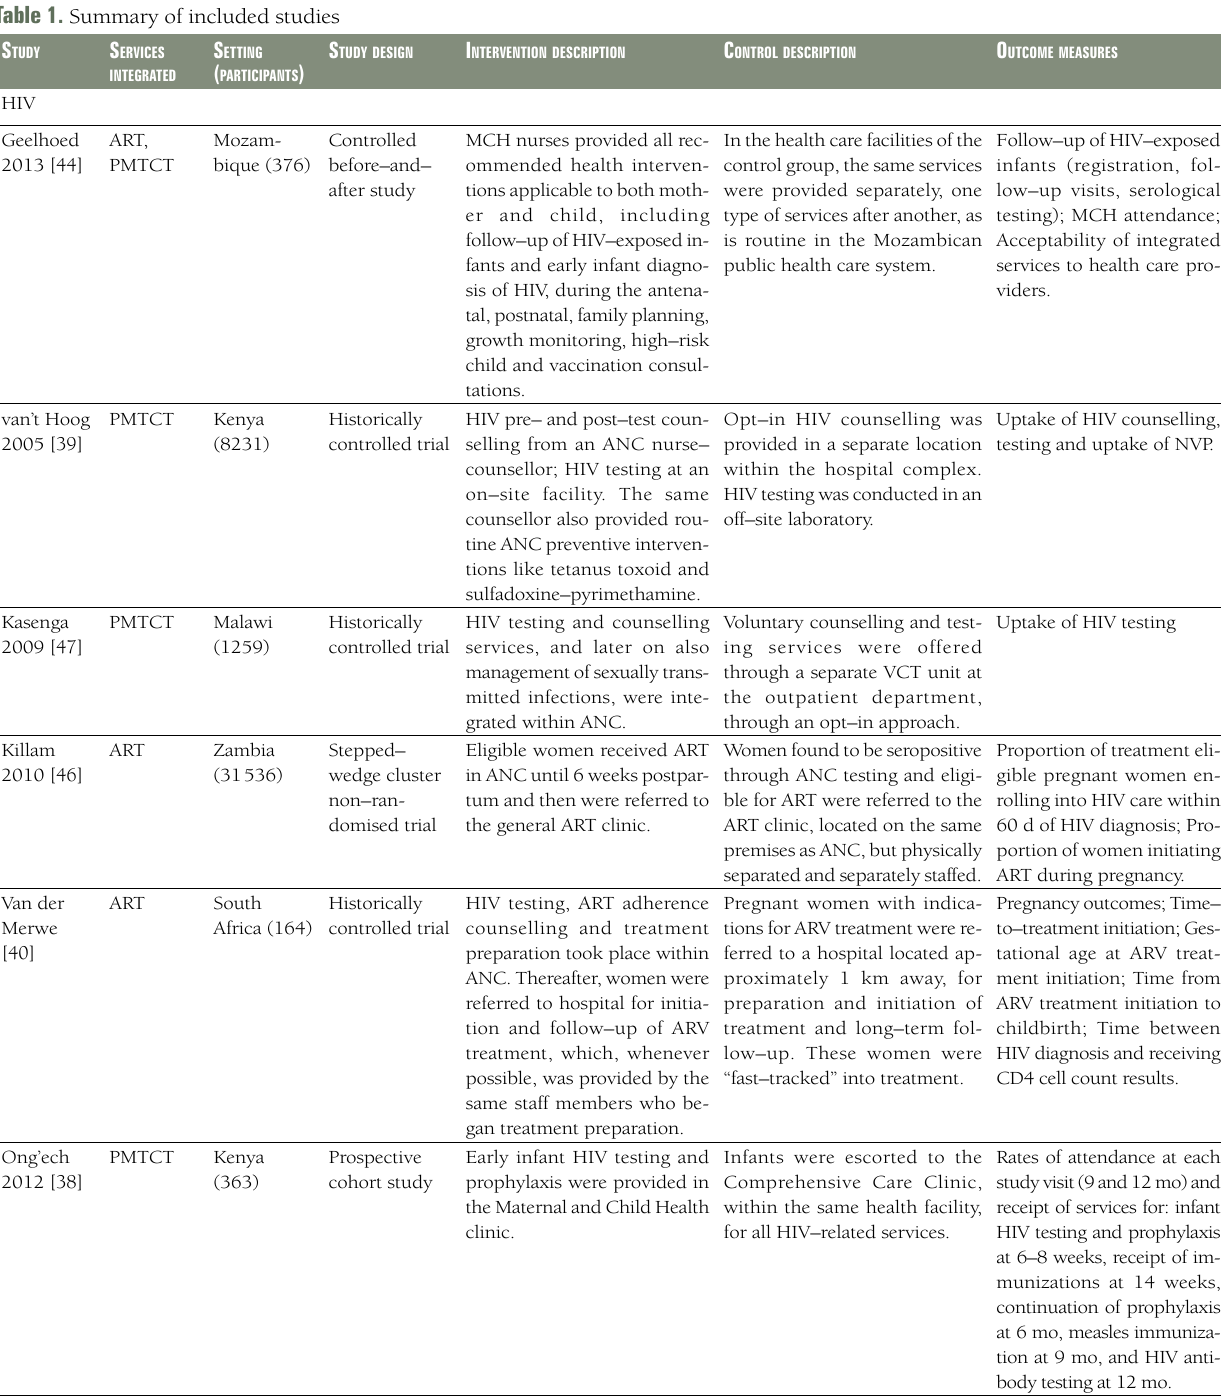
Table 1. Summary of included